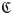
Numbers of ties of C, S, and Φ in TreeBASE, as functions of the trees’ numbers of leaves n.